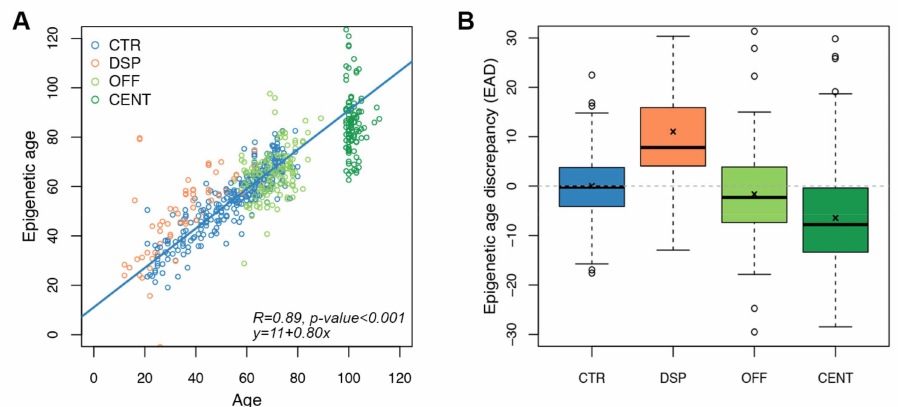
Figure 3. Application of the targeted epigenetic clock to increased and decreased biological age models. Each dot represents a subject. ( A ) Epigenetic age ( y -axis) vs. chronological age ( x -axis) in CTR, DSP (model of increased biological age), and in OFF/CENT (model of decreased biological age). Spearman correlation coefficient and the equation of the regression line are reported ( B ) Boxplots of epigenetic age discrepancy (EAD) values in the four categories of subjects considered in the validation of the targeted epigenetic clock; mean is indicated by the x